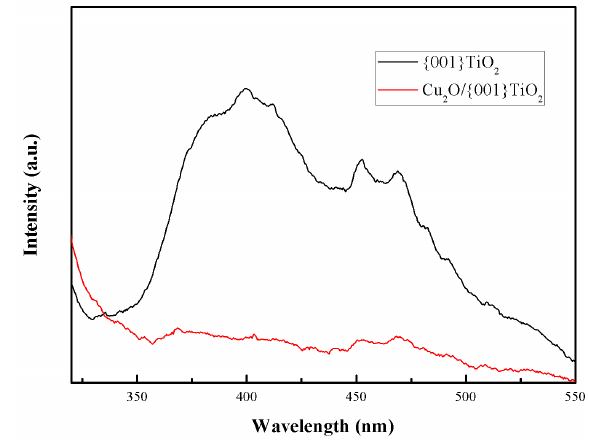
Figure 8. Fluorescence spectra of catalysts.